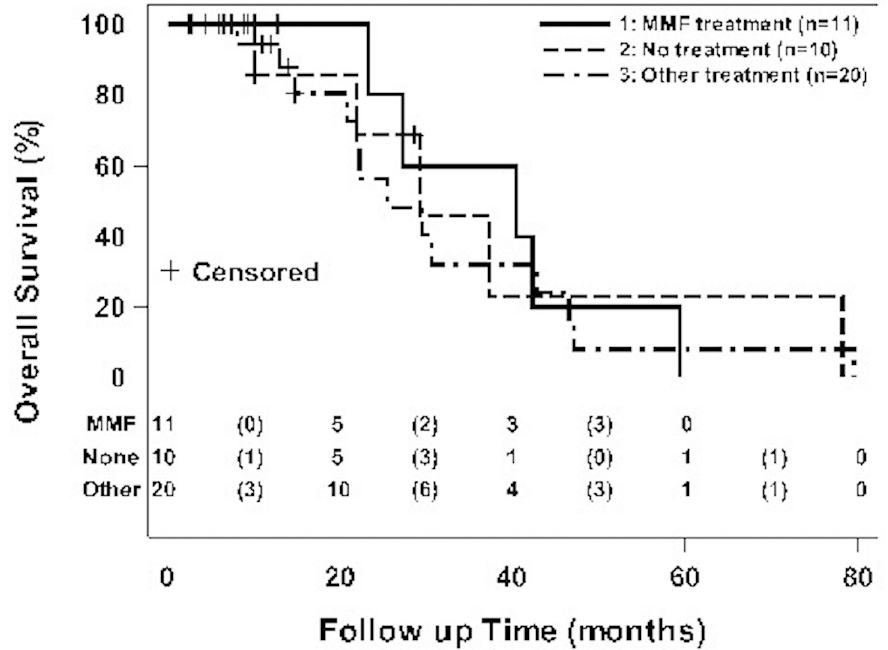
Fig 4. Kaplan-Meier distribution for the probability of overall survival. p-value = NS using log-ranktest.